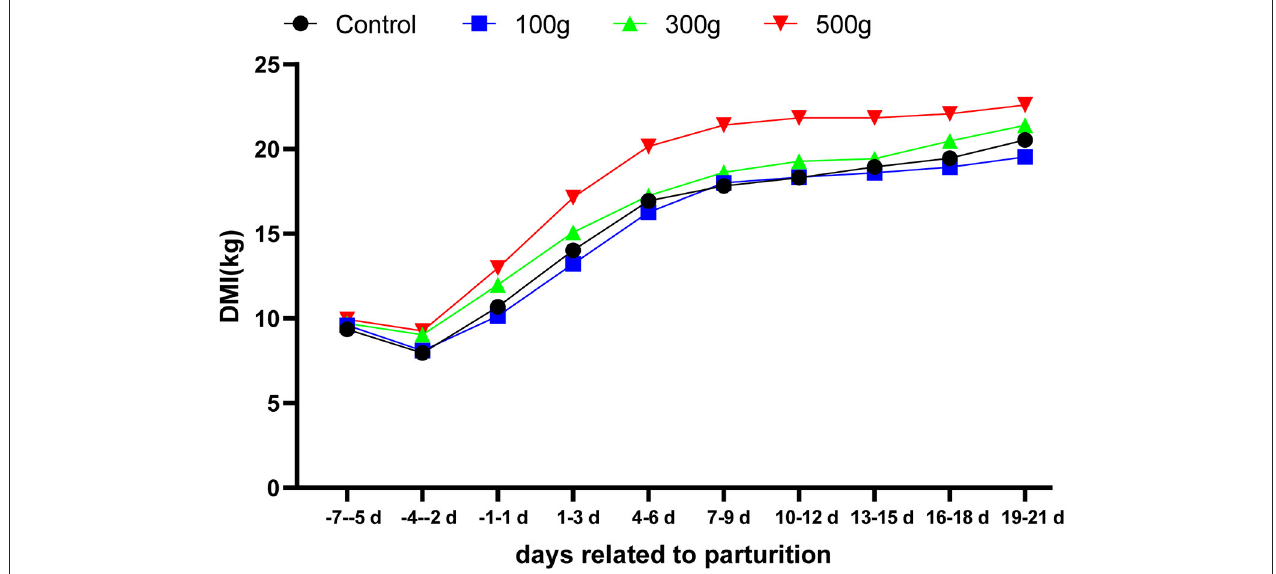
FIGURE 2 | Effects of dietary TCMF4 on DMI in peripartal dairy cows. DMI was collected during the 3-d metabolic measurements for each period. Daily averages are represented. The control group was fed an essential diet: TCMF4 groups (control diet supplemented with